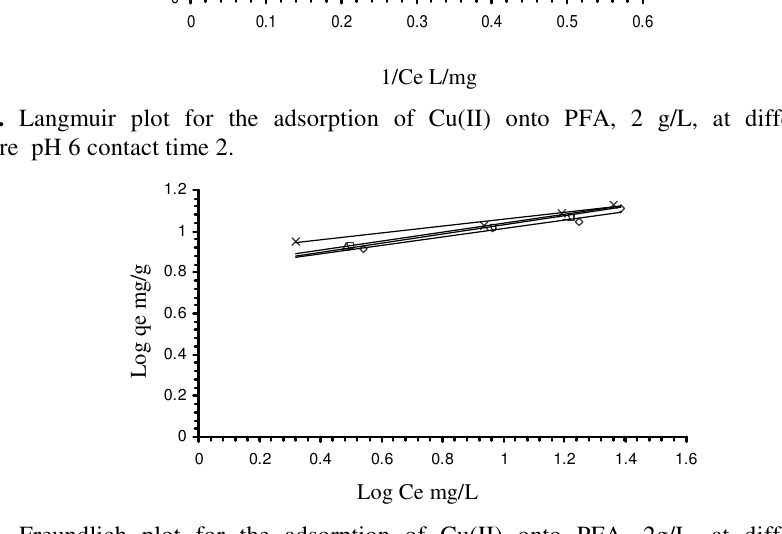
Figure 7. Freundlich plot for the adsorption of Cu(II) onto PFA, 2g/L, at different